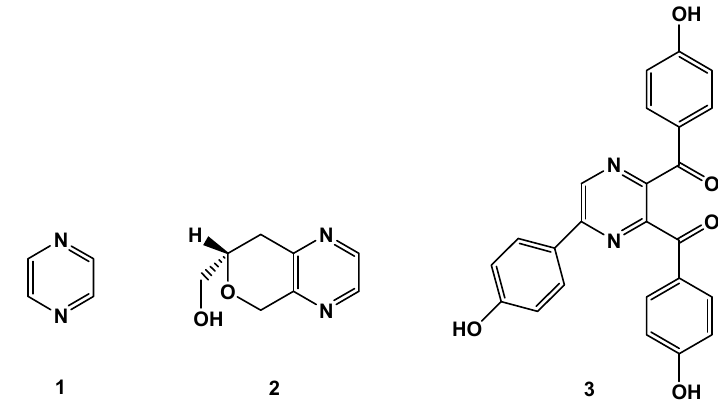
Figure 1. Structures of pyrazines 1 – 3 .